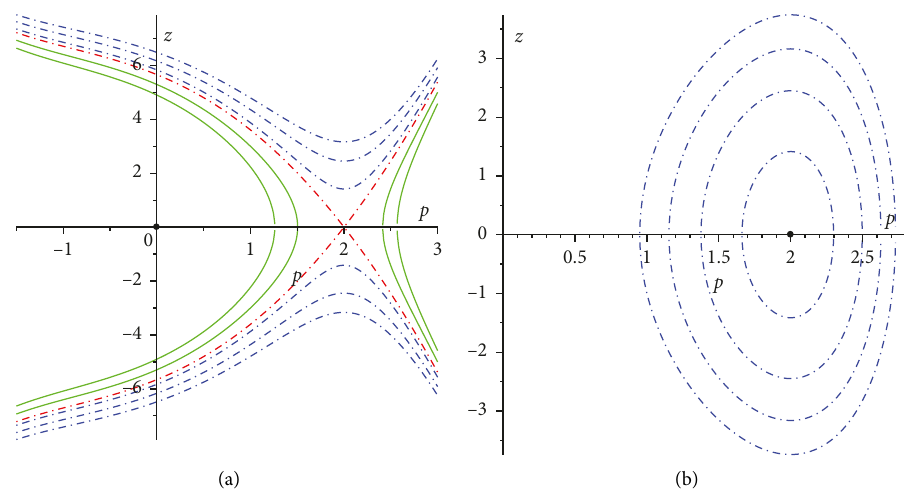
c n 1 (cid:31) 0 and 2 (cid:31) 0. (a) 4 (cid:31) 1 and (b)